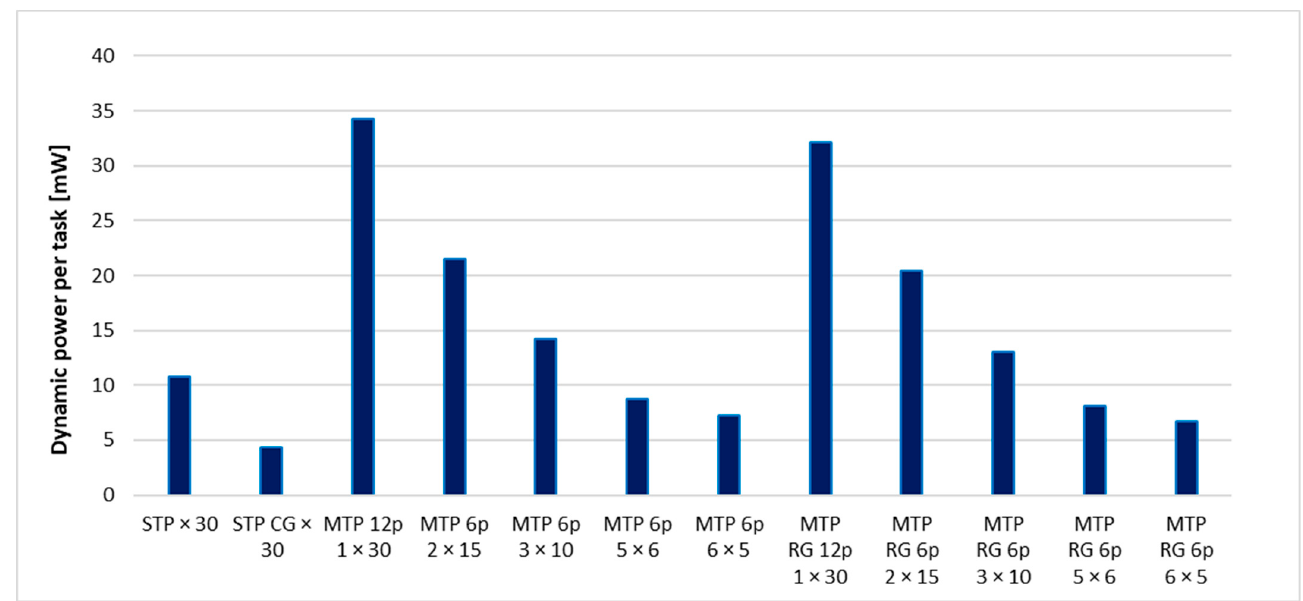
Figure 14. The comparison of the average dynamic power consumed by a single task by different structures with SP = 150.